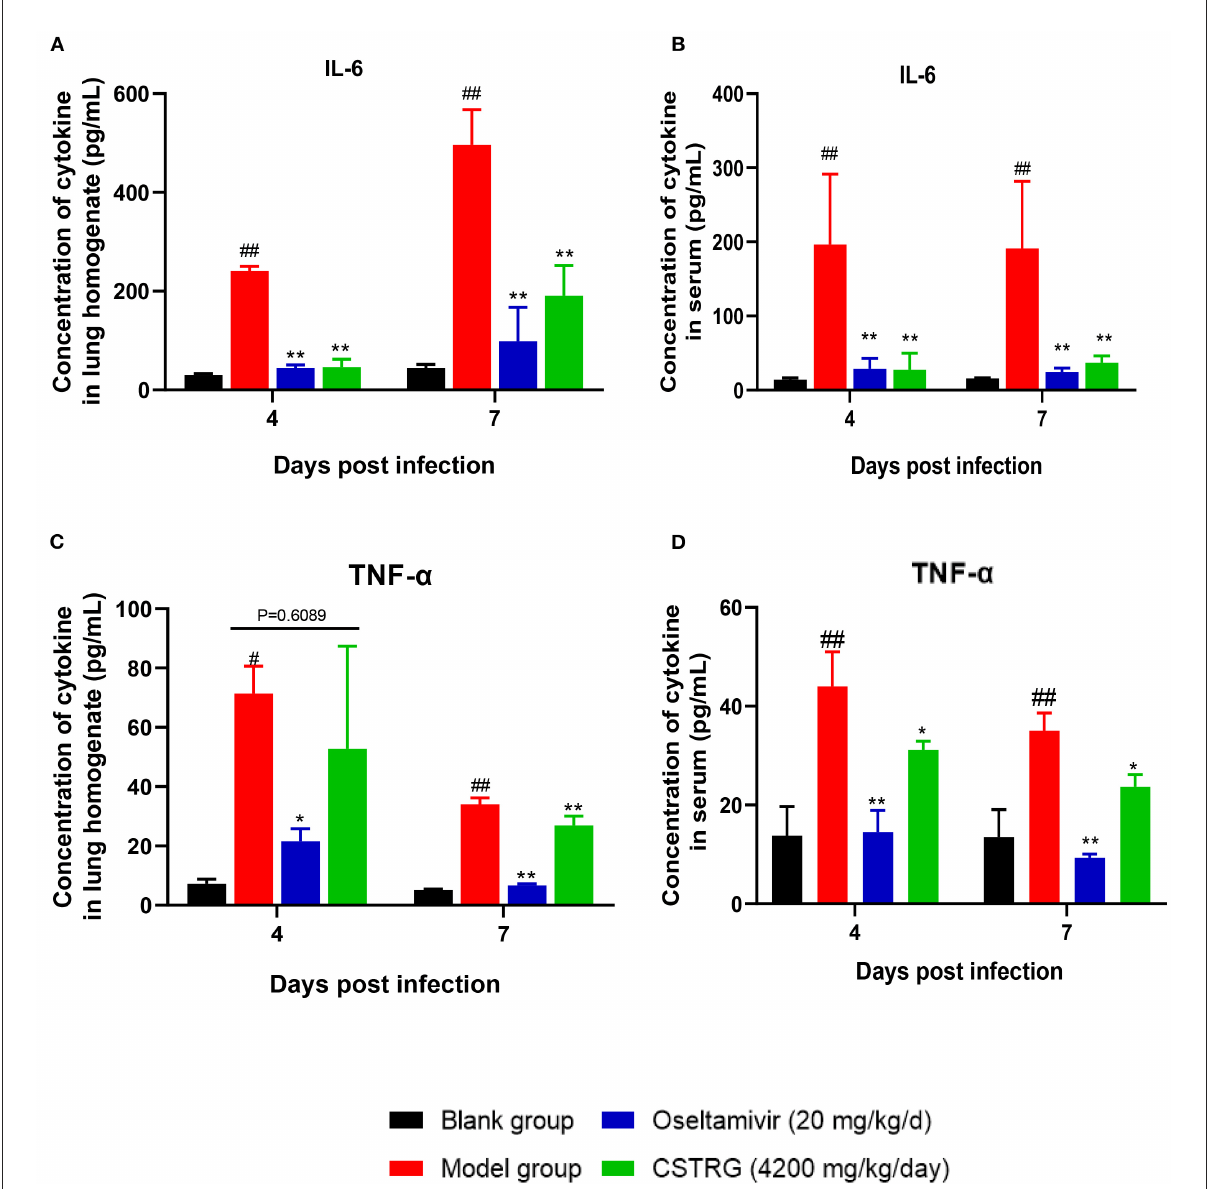
FIGURE3 CSTRG shows anti-inflammatory activity against IAV infection in mice. (A,B) IL-6 secretion levels in lung tissues and serum. (C,D) TNF- α secretion levels in lung tissues and serum. The data are presented as the means ± standard deviations of the results ( n = 3), compared with